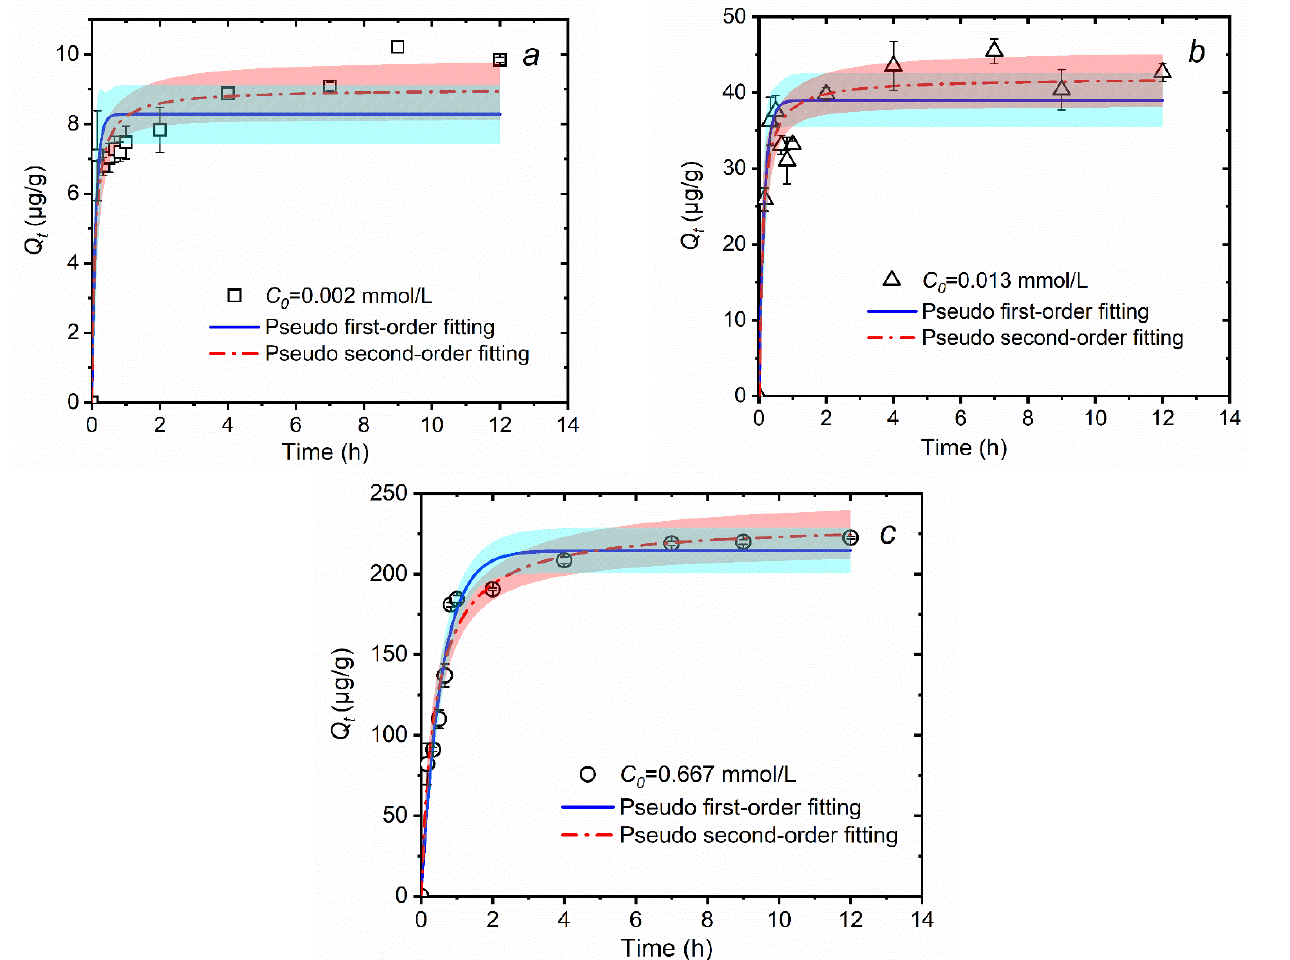
Figure 2. Kinetic adsorption of MTAs V on the natural sediment and their fitting curves using pseudo-first-order and pseudo-second-order models, in which the initial concentrations of MTAs V ( C 0 ) are 0.002 ( a ), 0.013 ( b ), and 0.667 ( c ) mmol/L, respectively. The shadow represents the confidence band under the 95% confidence level for fitting curves.